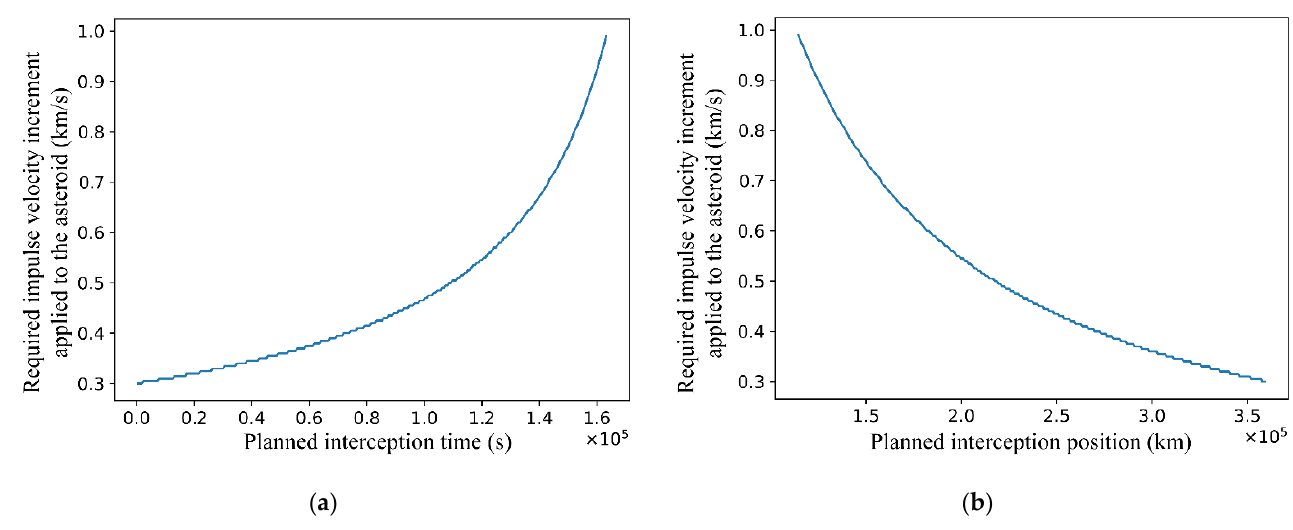
Figure 6. The graph of || || v - i t and || || v - p d variation. ( a ) || || v - i t and ( b ) || || v - p d .